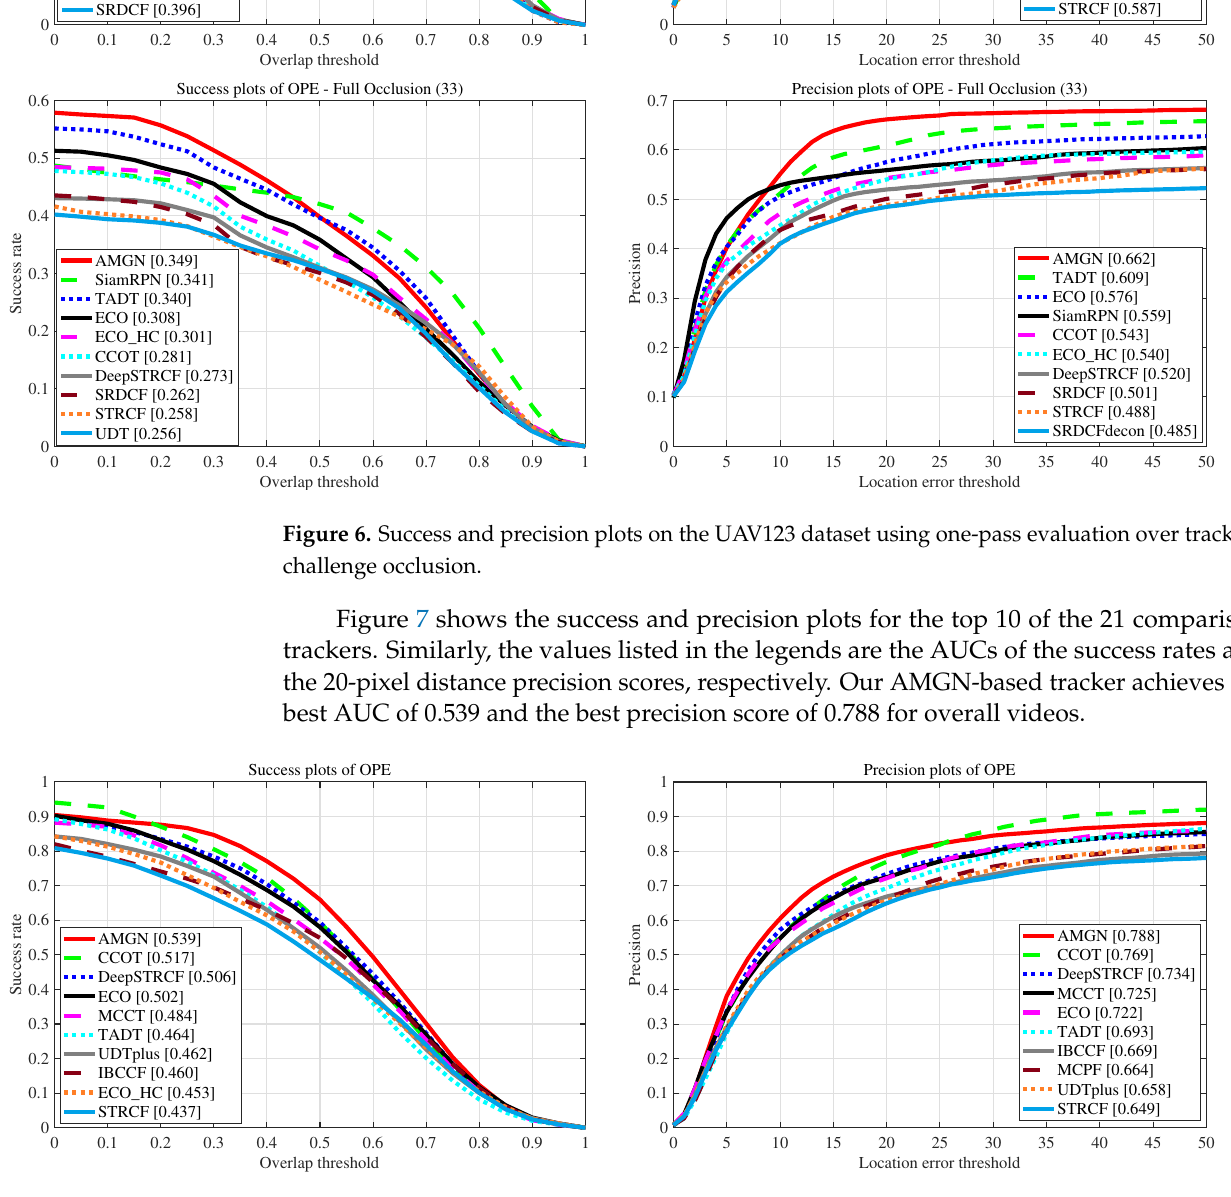
Figure 7. Success and precision plots on the DTB70 dataset using one-pass evaluation.